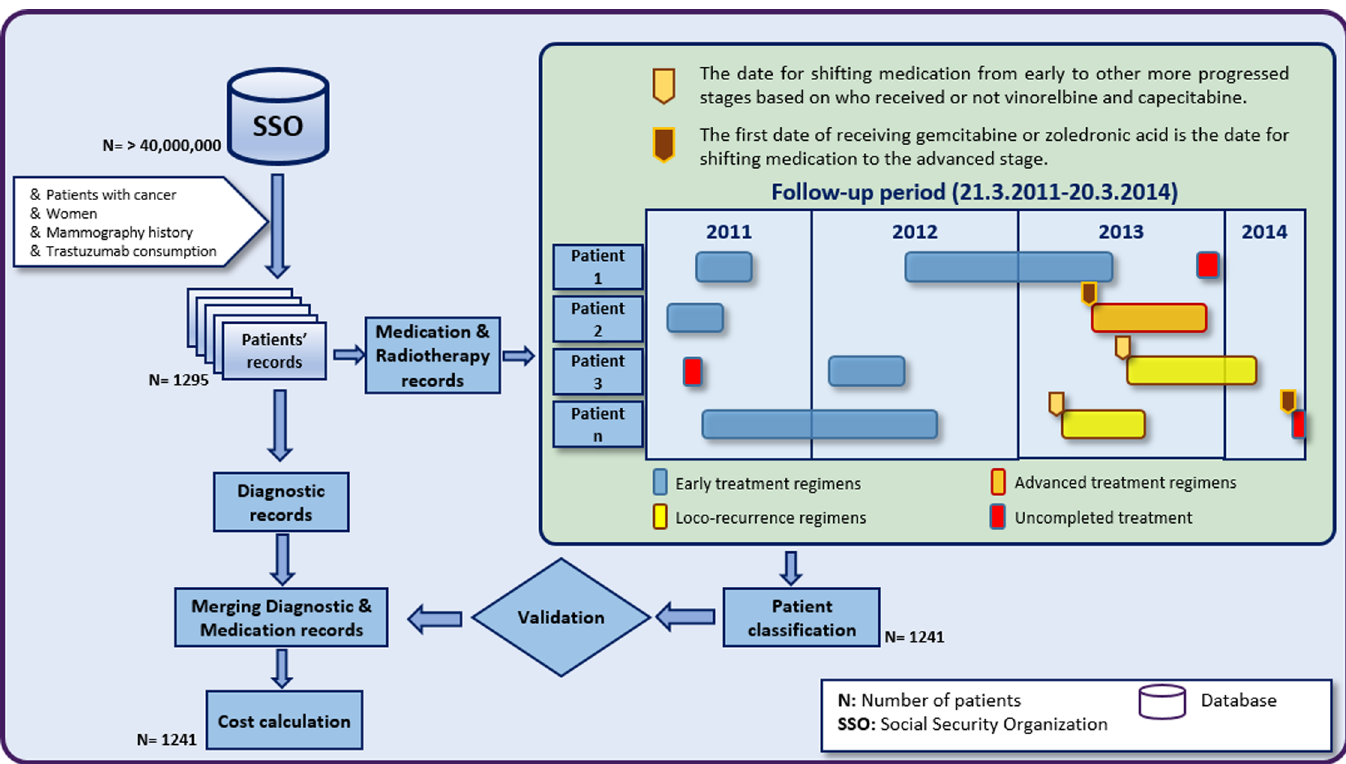
Fig 1. An overview of the different steps of the